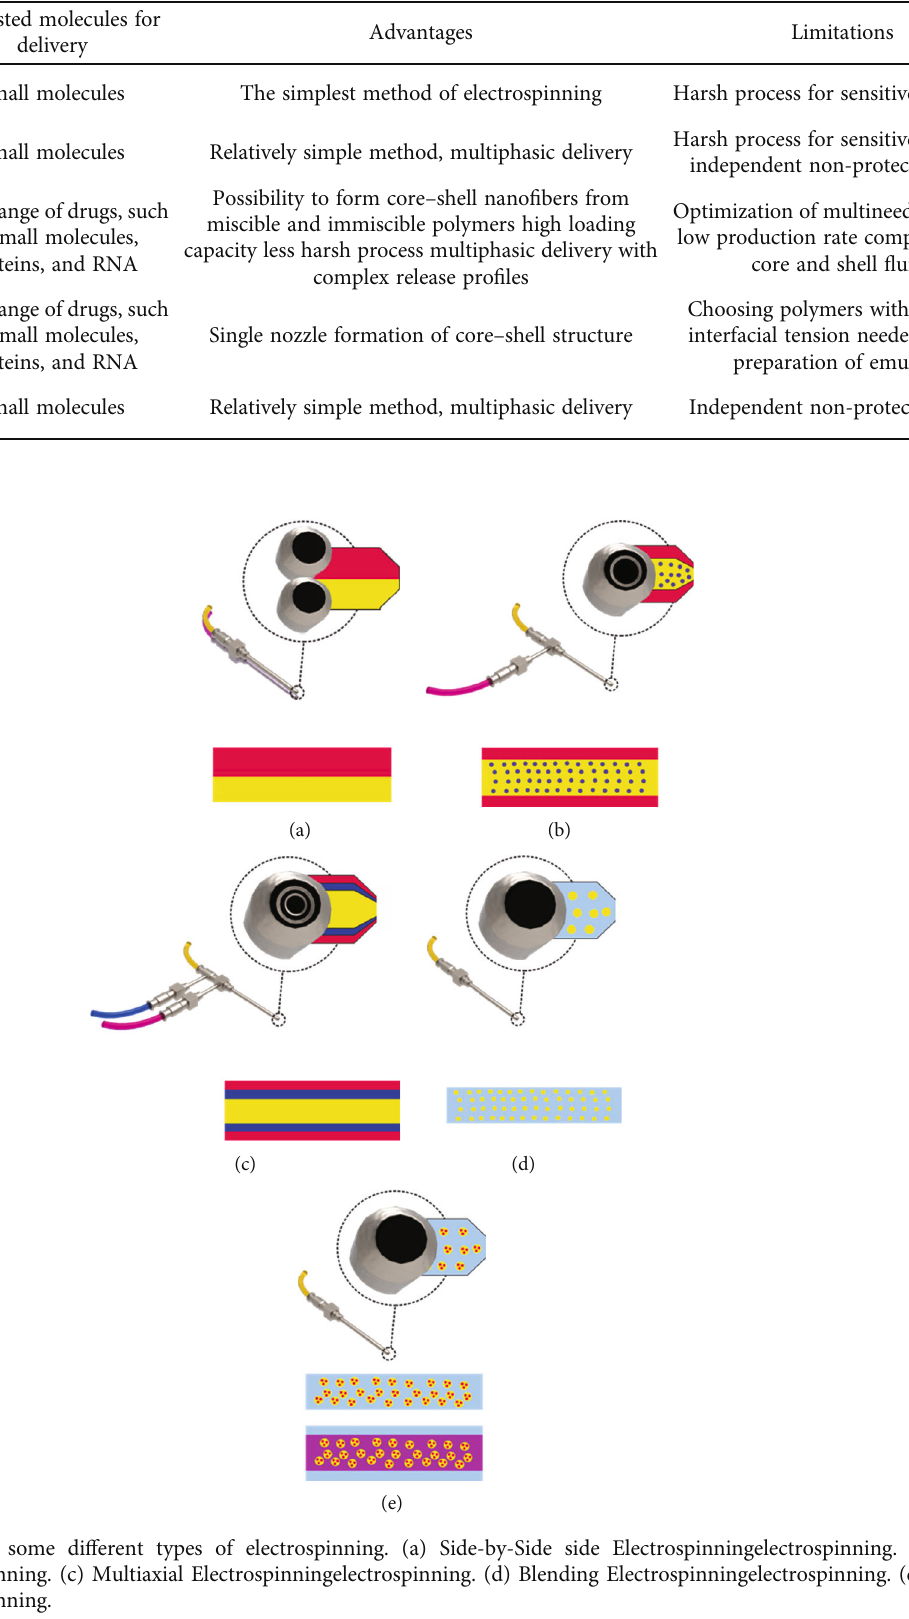
Table 1: Summarized information about di ff erent types of electrospinning.